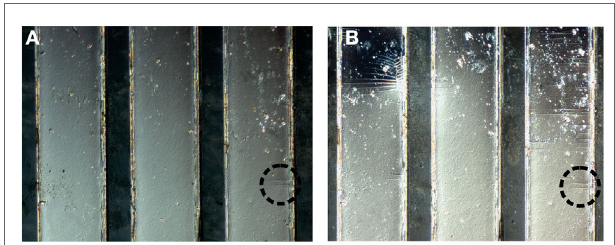
FigUre 14 | nomarski differential interference contrast images of fatigue cracks in the top Parylene layer covering three traces of a PaMaP devices after (a) 2k bend cycles and (B) 5k bend cycles . Metal regions are wide, light gray strips and Parylene appears as thin, dark gray strips. The majority of cracks appeared after 5k bend cycles; however, the dashed circle marks cracks present after 2k cycles (circle is 200 μ m in